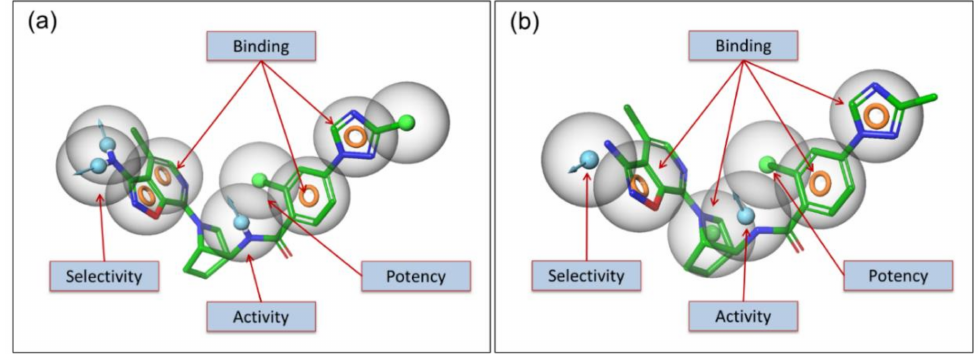
Figure 6. Pharmacophore based criteria is shown for potency and selectivity. The pharmacophoric descriptions are represented for potency, selectivity and both together for